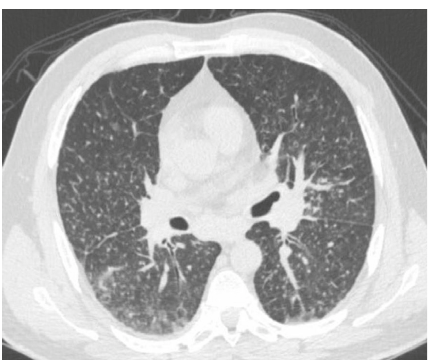
Figure 1: CT chest showing diffuse micronodules in all five of his lobes in a perilymphatic and centrilobular distribution, as well as a few scattered calcified granulomas.